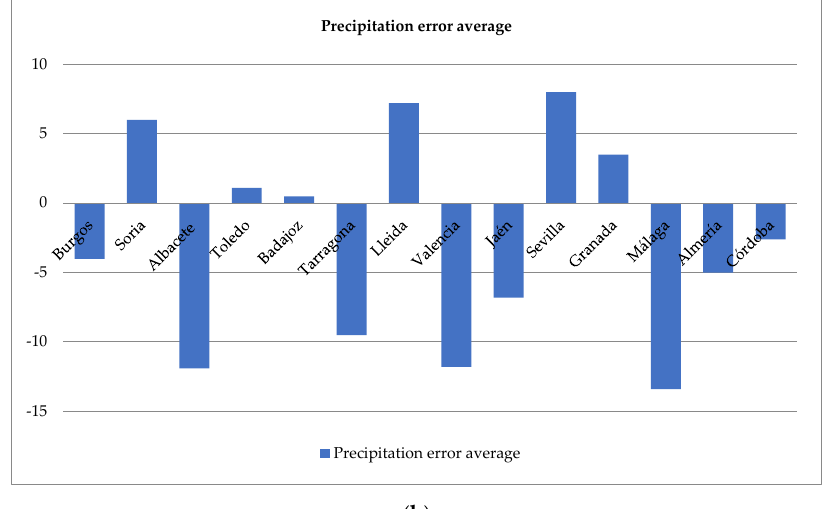
Figure 3. Precipitation error average. The errors did not exceed 20 mm for the monthly average in precipitation in ( a ) either in ( b ).